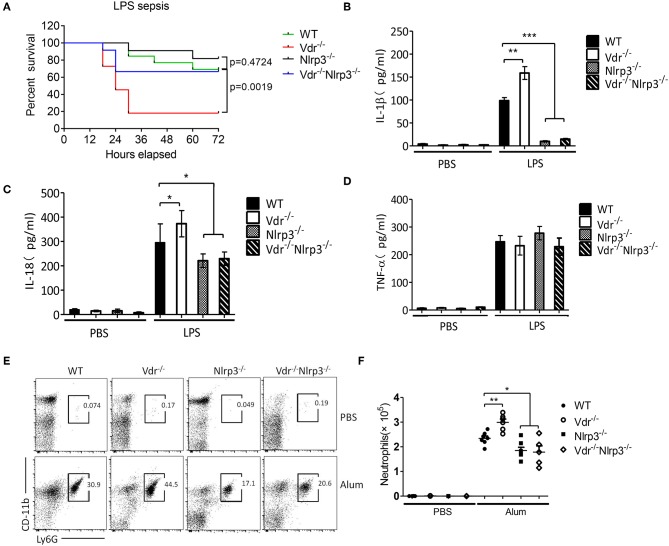
Vitamin D receptor deficiency promotes LPS-induced systemic inflammation and Alum-induced peritoneal inflammation via suppression of the NLRP3 inflammasome. (A) Survival of VDR+/+NLRP3+/+, VDR−/−NLRP3+/+, VDR+/+NLRP3−/−, and VDR−/−NLRP3−/− mice (n = 10 mice/group) intraperitoneally injected with LPS (8 mg/kg body weight) over a period of 72 h. (B–D) Serum IL-1β, IL-18, and TNFα ELISAs at 6 h after intraperitoneal injection of LPS (8 mg/kg body weight) into VDR+/+NLRP3+/+, VDR−/−NLRP3+/+, VDR+/+NLRP3−/−, and VDR−/−NLRP3−/− mice. (E,F) Representative FACS plots of peritoneal CD11b+ Ly6G+ cells (neutrophils) from VDR+/+NLRP3+/+, VDR−/−NLRP3+/+, VDR+/+NLRP3−/−, and VDR−/−NLRP3−/− mice at 12 h after an intraperitoneal injection with alum (n = 5 mice/group). *p < 0.05, **p < 0.01, ***p < 0.001, NS p > 0.05. Values are the mean ± SEM of five mice per group. Both male and female mice were randomly assigned. Data in (B–D,F) are representative of three independent experiments.